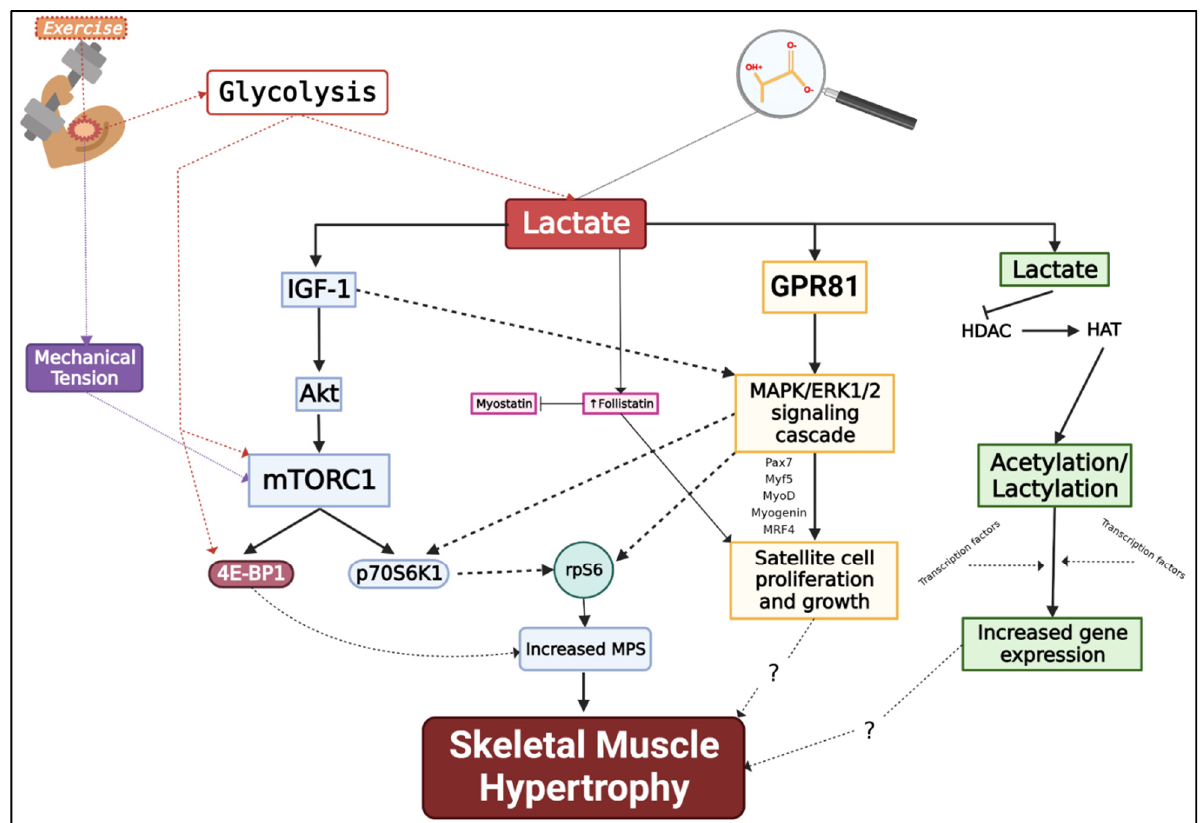
Figure 2. Potential Anabolic Pathways Lactate Influences for Skeletal Muscle Hypertrophy. IGF-1 = Insulin like growth factor 1; Akt = Protein kinase B (PKB); mTORC1 = Mammalian target of rapamycin complex 1; 4E-BP1 = Eukaryotic translation initiation factor 4E (eIF4E)-binding protein 1; p70S6K1 = Ribosomal protein S6 kinase beta-1; GPR81 = G protein-coupled receptor 81; MAPK = Mitogen-activated protein kinase; ERK1/2 = Extracellular signal-regulated kinase 1/2; Pax7 = Paired Box 7; Myf5 = Myogenic factor 5; MyoD = Myoblast determination protein 1; MRF4 = Myogenic regulatory factor 4; HDAC = Histone deacetylases; HAT = Histone